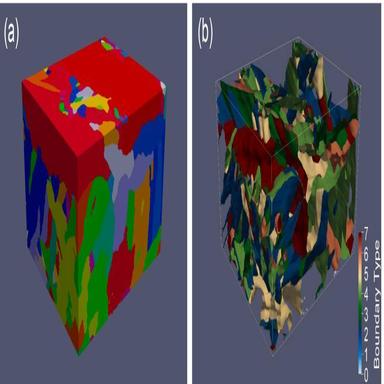
(a) The fully reconstructed and segmented dataset in unique grain color and (b) the grain boundary mesh colored by boundary type as defined in Section 3.2.1.